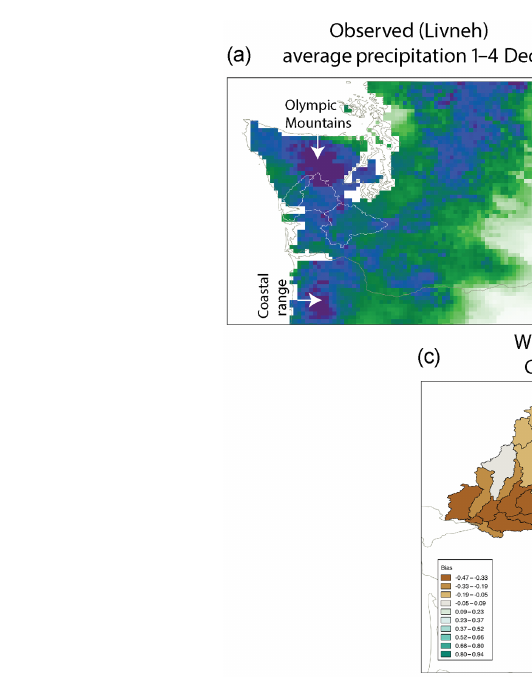
Figure 4. (a) Observed daily precipitation (mm day − 1 ) averaged for 1–4 December 2007 from Livneh et al. (2013), (b) WRF-control simulated precipitation for the same period and (c) bias in simulated precipitation for each of the HEC-HMS sub-basins within the Chehalis